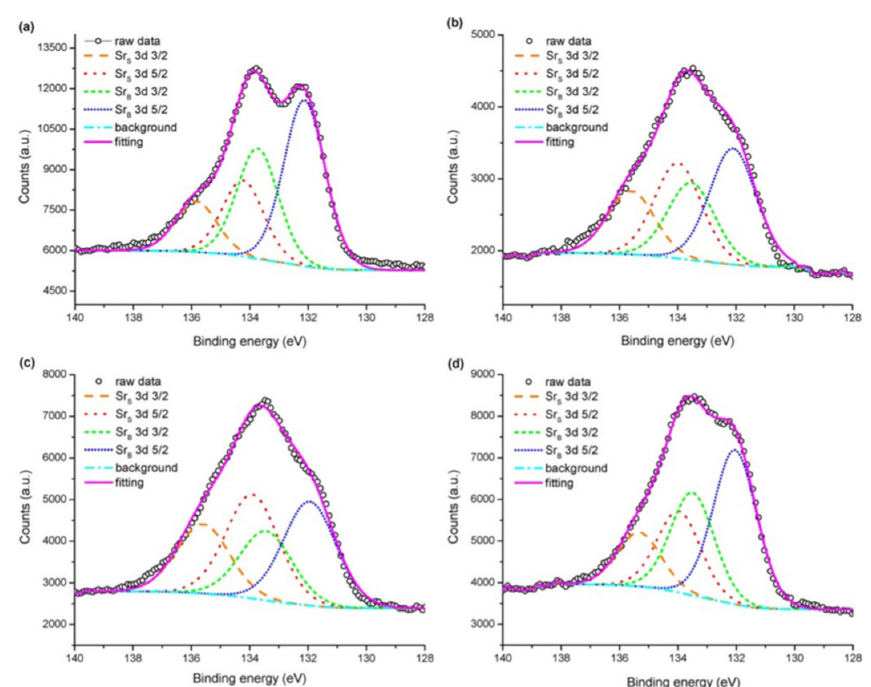
Figure 5. Peak fitting results of Sr spectra for ( a ) raw LSCF powder, ( b ) freshly prepared LSCF electrode, ( c ) LSCF electrode after 24 h annealing, and ( d ) nitric acid-treated LSCF electrode after annealing [36] (© The Electrochemical Society. Reproduced by permission of IOP Publishing. All rights